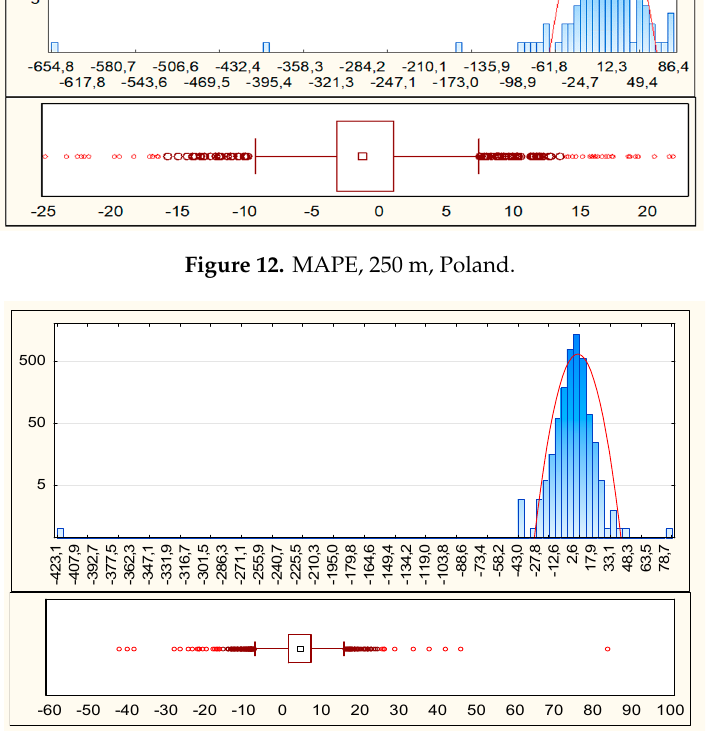
Figure 13. MAPE, 250 m, Portugal.